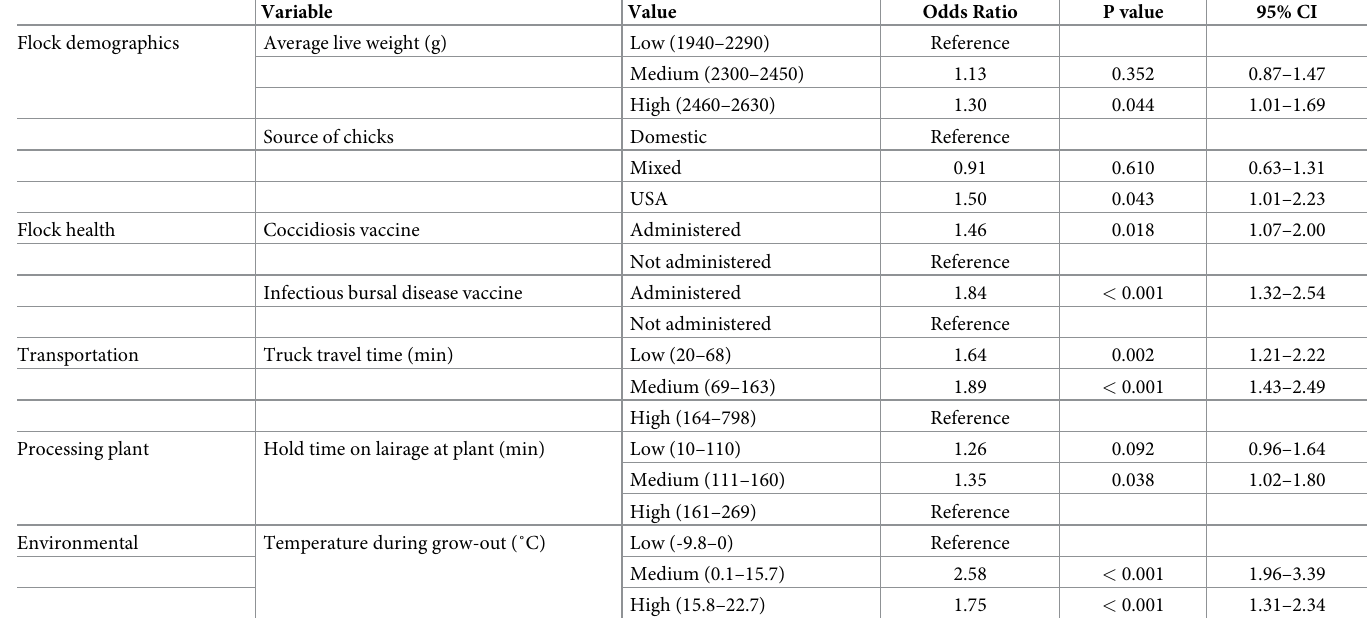
Table 4. Results of the final random intercept 2-level (flock-fillet) multivariable logistic regression model for spaghetti meat, in a cohort of 9,250 chicken breast fil- lets collected at two processing plants between 2019–2020 in Ontario,